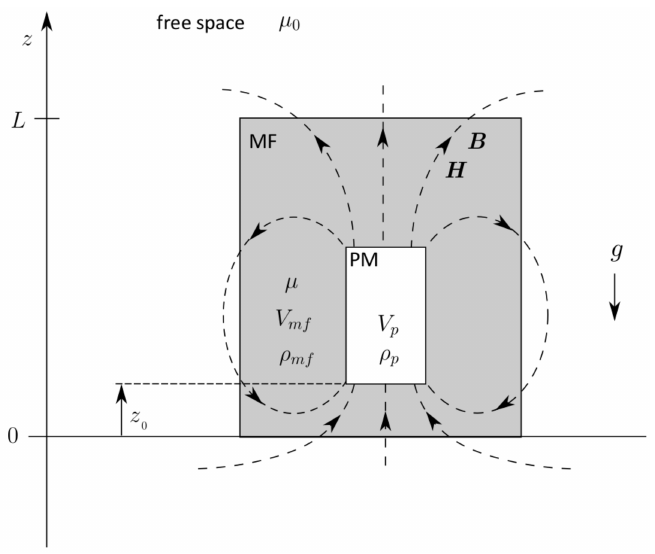
Figure 5. Schematic representation of a magnetic field caused by the PM levitating in the MF. A specific gravitational energy, or gravitational energy per unit of volume, can